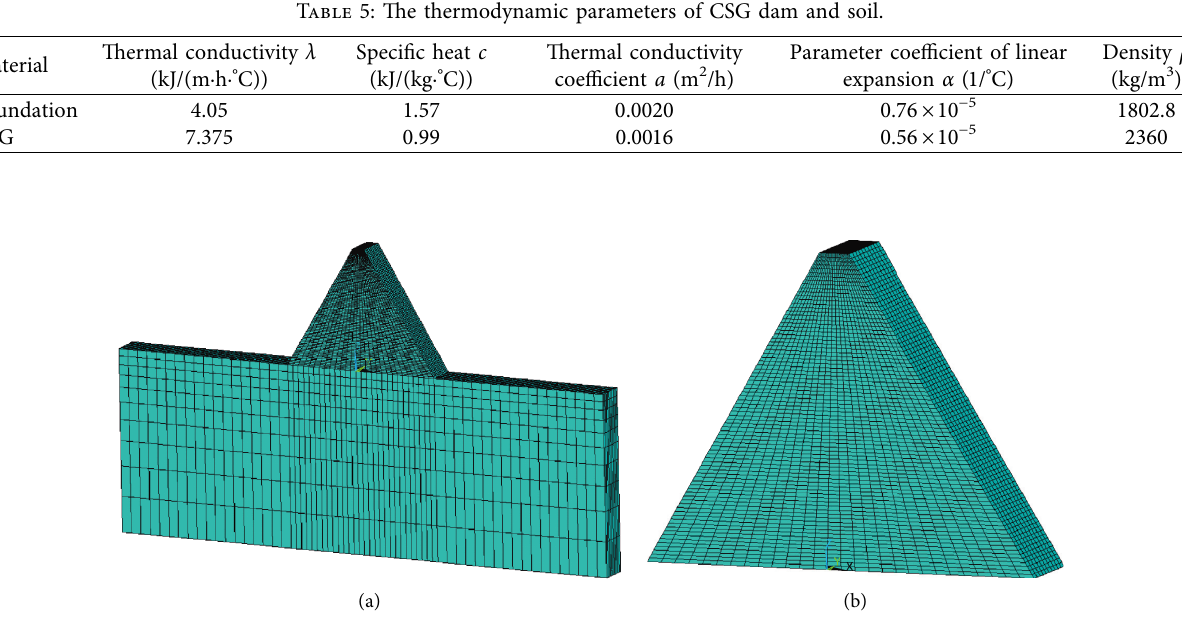
Figure 7: The mesh of finite element model. (a) The integral calculation model. (b) The dam body calculation model.